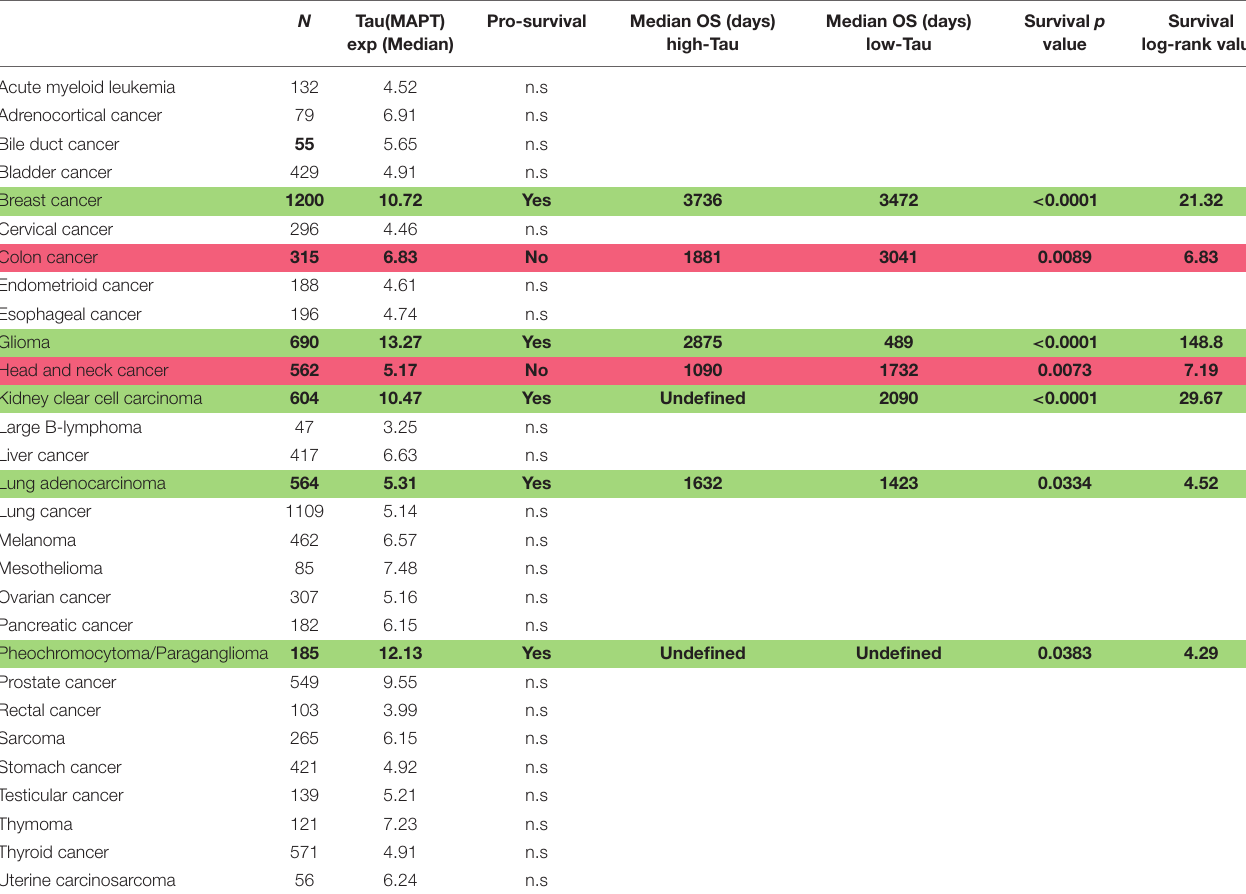
TABLE 2 | Prognostic value of Tau/MAPT in different